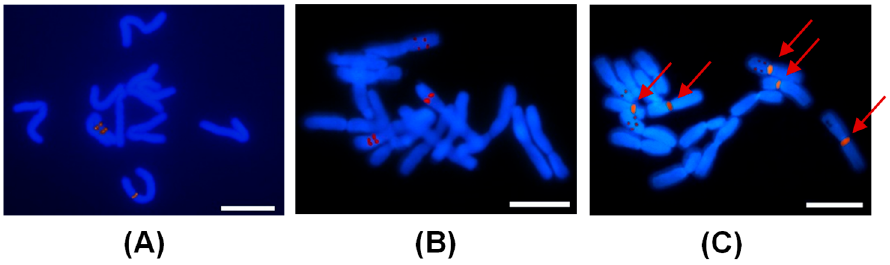
Figure 8. 5S rDNA-FISH analysis of mitotic chromosome pairings in ( A ) ‘Luo Yang Hong’ and ( B ) ‘Garden Treasure’, and ( C ) the combination of 5S rDNA-FISH and GISH in the same cell of ‘Julia Rose’ with P. delavayi var. lutea as the GISH probe with five red arrows indicating the GISH signals.